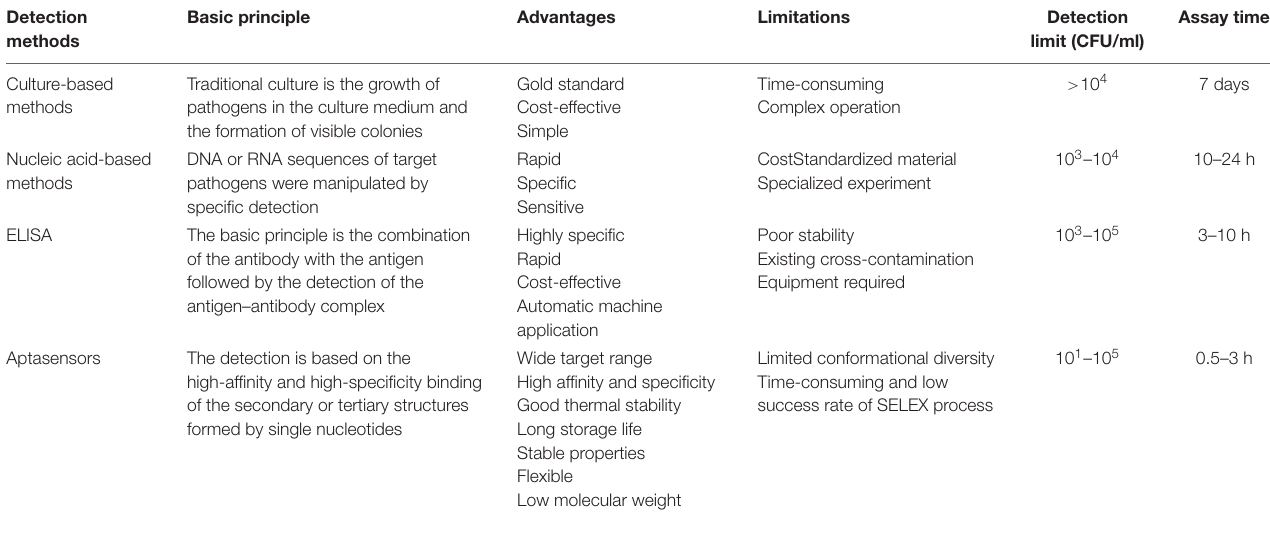
TABLE 1 | Comparison of conventional methods and aptasensors for detection of S. aureus